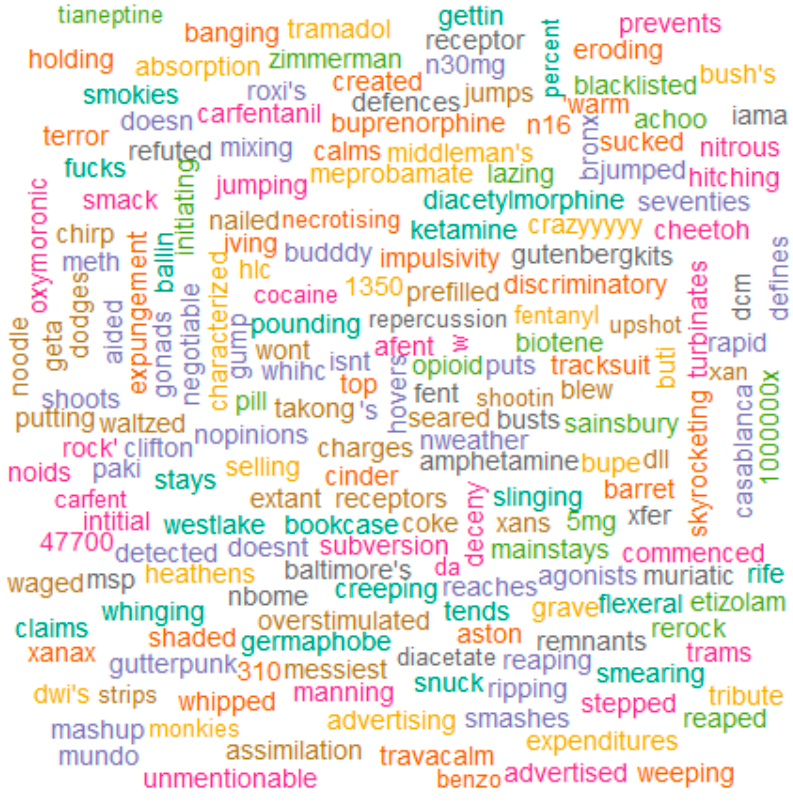
Figure 3. A word cloud generated from the most aligned words to the decision direction separating author vectors from / r / Opiates and / r / CasualConversation. This was generated using the GloVe embedding based on / r / Opiates authors, with a 78 thousand size vocabulary.